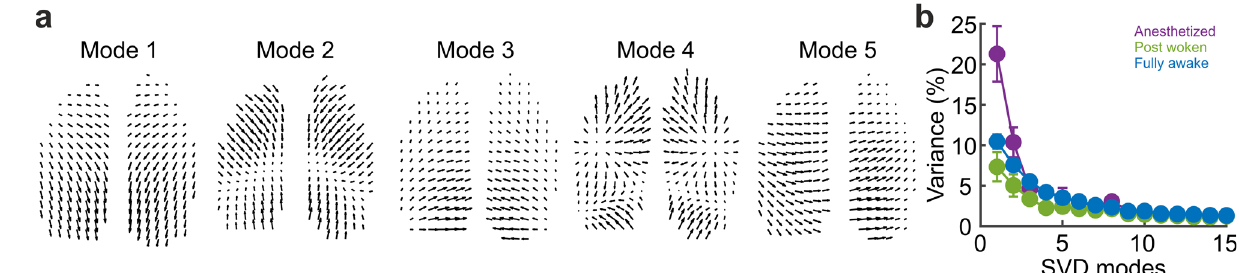
Fig. 3 | Principal modes of the phase velocity fi elds and their contributions under three states. a Top 5 modes obtained by the singular value decomposition of all phase velocity fi elds (SVD variance of mode 1: 16.5%, mode 2: 9.8%, mode 3: 5.4%, mode 4: 4.2%, mode 5: 3.9%; Top 5 modes total: 39.8%, each vector for each